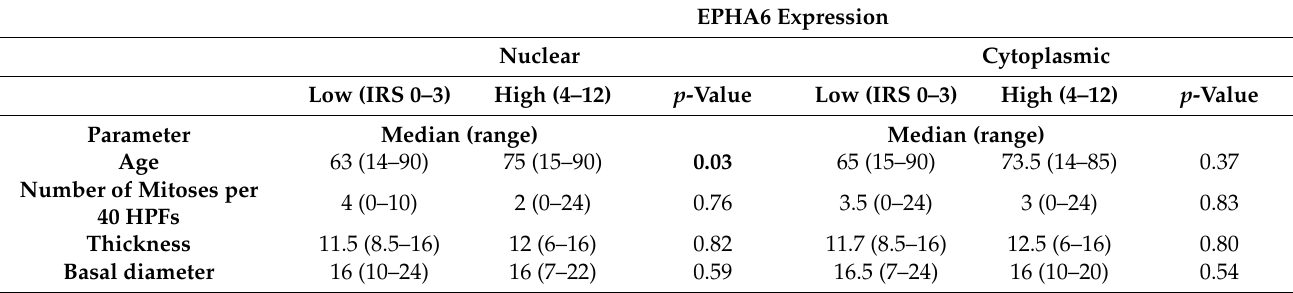
Table 4. Associations of nuclear and cytoplasmic EPHA6 with clinicopathological